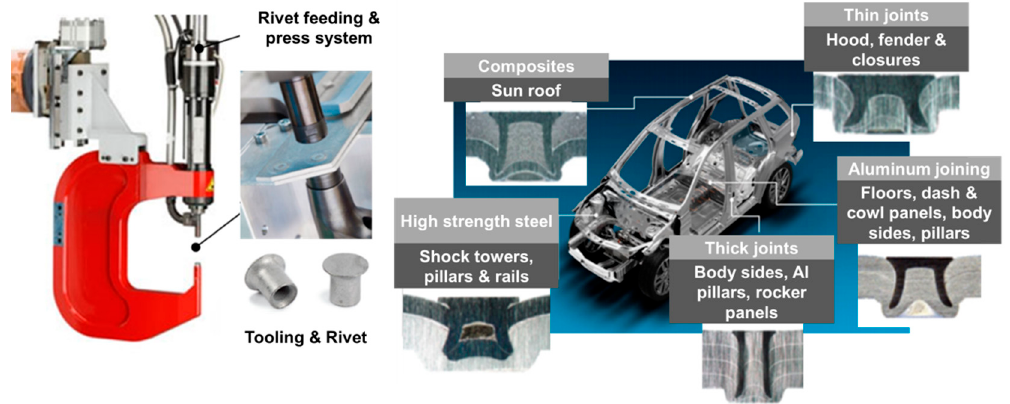
Figure 7. Self-piercing riveting facility and its applications in the automotive industry. terlock distance, and the minimum remaining bottom materials’ thickness, as shown in Figure 8 [78,79]. The rivet head height is important for the surface quality of the upper sheet. The interlock distance is the most important joint quality because it determines the strength of an SPR joint. Although the minimum remaining bottom materials’ thickness does not influence the joint strength significantly, it is important for NVH (noise, vibration, and harshness) performance and corrosion. Additionally, other joint quality aspects are considered by the defects of SPR joints, such as the rivet buckling, cracks at the lower sheet, and insufficient interlock distance.